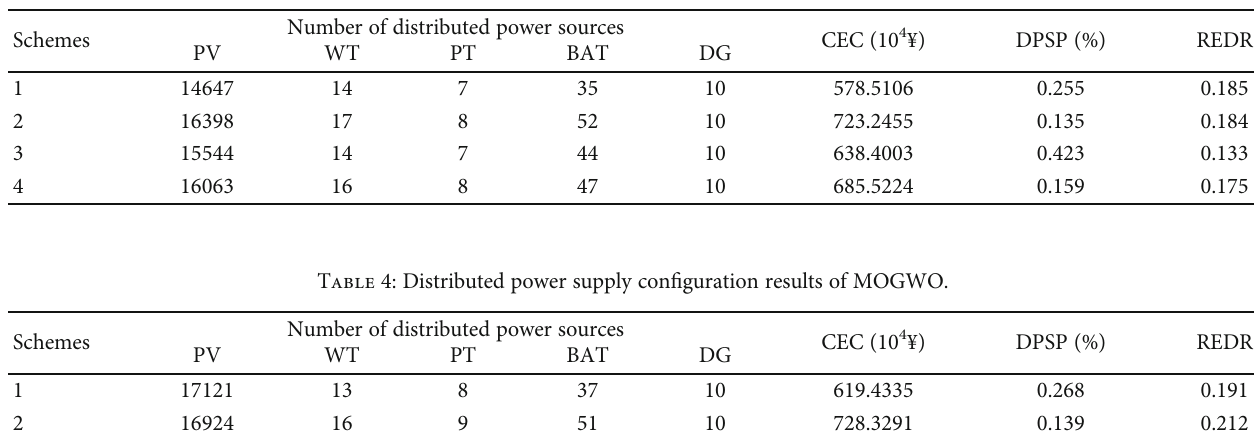
Table 3: Distributed power supply con fi guration results of IMOGWO.